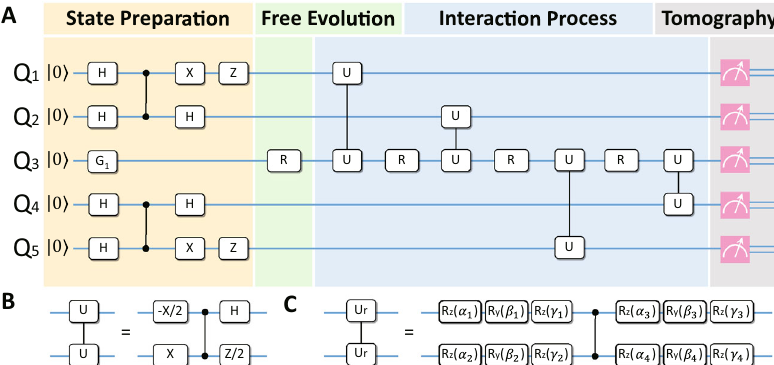
Fig. 1 Description of the quantum resetting protocol. a The quantum circuit. During state preparation (yellow), the target qubit Q 3 is set with the single-qubit gate G 1 , and the probe pairs Q 1,2 and Q 4,5 are prepared in the Bell state ψ (cid:2) j i . The single-qubit gate R is then applied on the target qubit during the evolution phase (green). The probes are then made to interact with the target, with the bipartite unitary operator U governing the interaction. We note that the bipartite operation between the next-nearest-neighboring qubits Q 1 and Q 3 is realized as the bipartite operation between Q 2 and Q 3 and then the SWAP operation between Q 1 and Q 2 (see “ Method ” for details), so as the operation between Q 5 and Q 3 . Finally, the fi ve-qubit combined state is obtained via quantum state tomography, which is then projected for a successful reset. b Realization of a gate sequence for the deterministic interaction operator U ¼ ð X (cid:3) Z þ i Y (cid:3) X Þ = interaction. Three single-qubit rotation gates perform an arbitrary rotation, the rotation angles of which are chosen randomly. Each rotation is applied on target and probe before and after the CZ